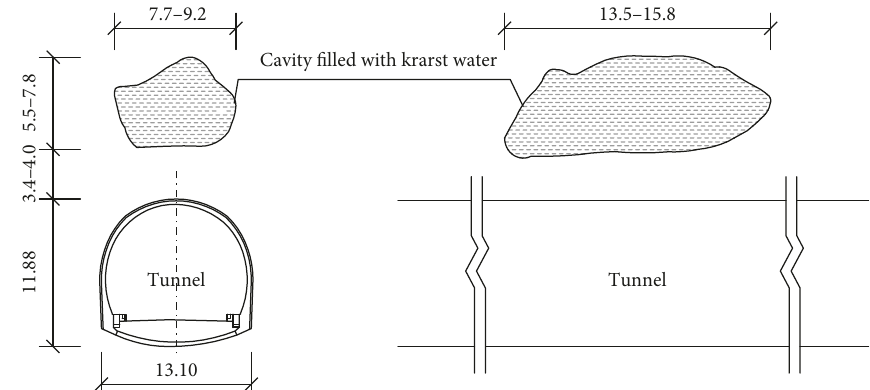
Figure 10: Cavity size and position relationship of tunnel and cavity.